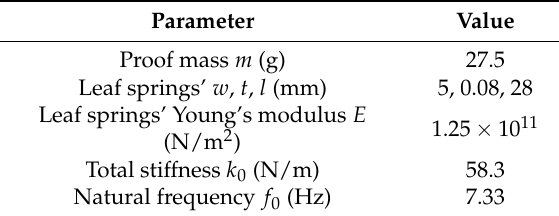
Figure 3. The design and implementation of the proposed spring-mass structure. ( a ) Design drawing of the spring-mass structure. ( b ) The actual spring-mass structure. Table 1. A typical set of parameters of the proposed spring-mass structure.